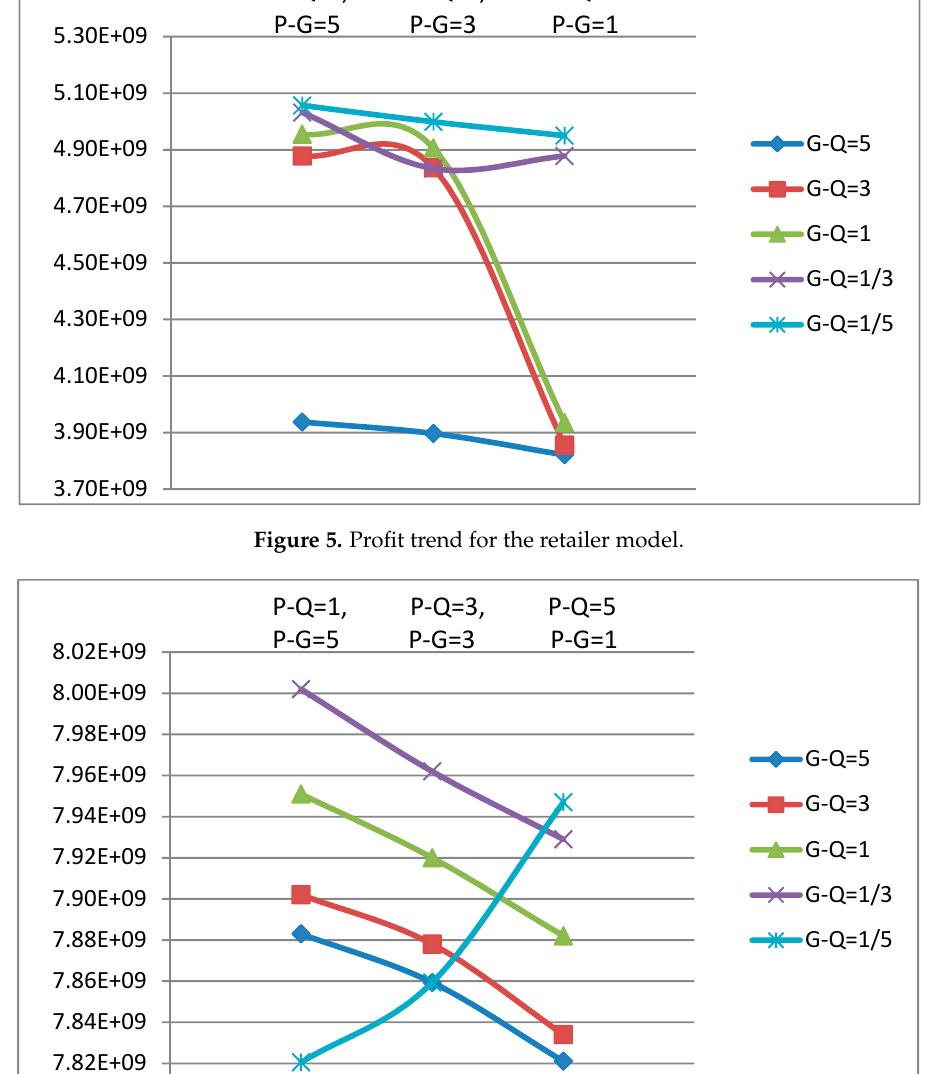
Figure 6. Profit trend for the joint supply chain model.